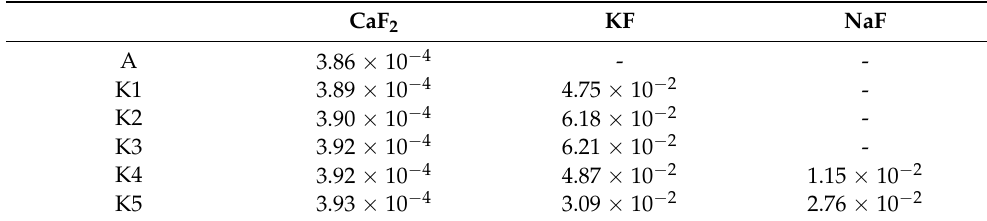
Table 2. The activity of each component at 1500 ◦ C using FactSage 8.0 software.